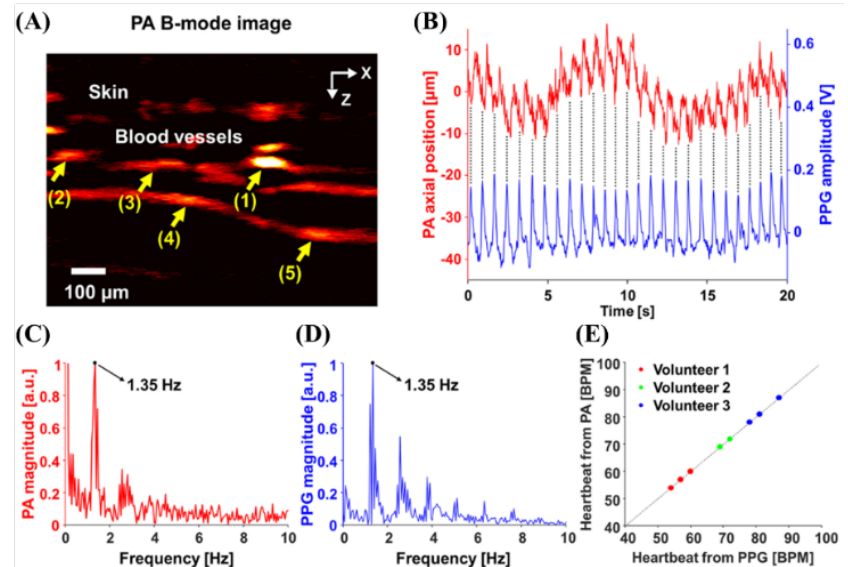
Figure 6. ( A ) Cross-sectional PA B-mode image of a human finger. Quantifications of ( A ) vascular movement. ( C , D ) Frequency responses of ( B ) and their dominant frequencies of 1.35 Hz. ( E ) Com- parison of the heart rates. Reprinted from J.Ahn et al., Photoacoustics, 2022, 27: 100374 [24], with permission of